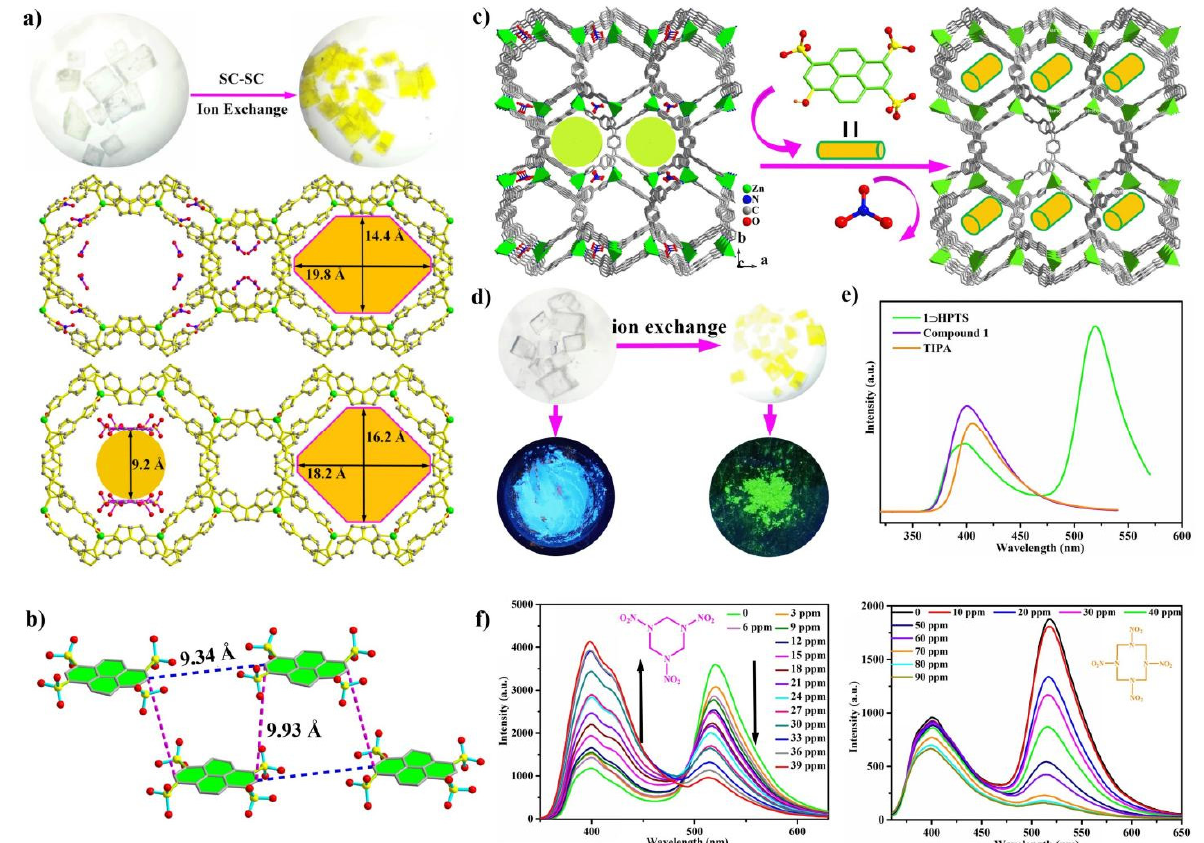
Figure 5. ( a ) Photograph of FIR-53 crystals, 3D framework of FIR-53 along the c axis, the window size from 19.8 × 14.4 Å 2 of FIR-53 to 20.2 × 17.3 Å 2 of SG7@FIR-53 along c axis. ( b ) Photograph of FIR-53 after ion exchange, the arrangement and configuration of SG73 − along the two sides of the channels. Reproduced with permission [69]. Copyright 2018, the American Chemical Society. ( c ) A 3D framework of compound FIR-54 after ion exchange. ( d ) Photographs show the colors of crystals before and after the trapping process in the two images above, and the fluorescence emission of the crystal powder before and after ion exchange under ultra-violet light in the two images below. ( e ) Photographs show the solid-state fluorescence emission of compound FIR-54, TIPA, and MOF É HPTS. ( f ) The fluorescence titrations of MOF É HPTS upon exposure to the aqueous solution of RDX and HMX. Reproduced with permission [79]. Copyright 2018, Royal Society of Chemistry.